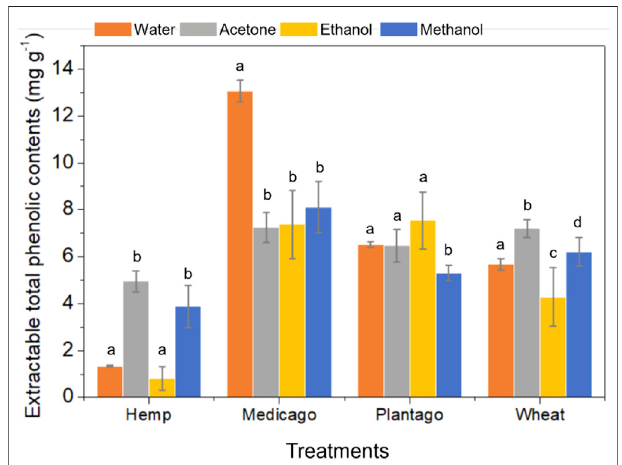
FIGURE 3 | Extractable total phenolic contents in each plant litter type (hemp, Medicago , Plantago , and wheat). Each plant litter extract was prepared using four different extraction solutions (deionized water, 80% acetone, 80% ethanol, and 80% methanol), and the Folin-Ciocalteu method was used to determine total phenolic concentrations. Signi fi cant differences ( p < 0.05; denoted with a-d) were determined using Tukey ’ s multiple comparison tests after one-way analyses of